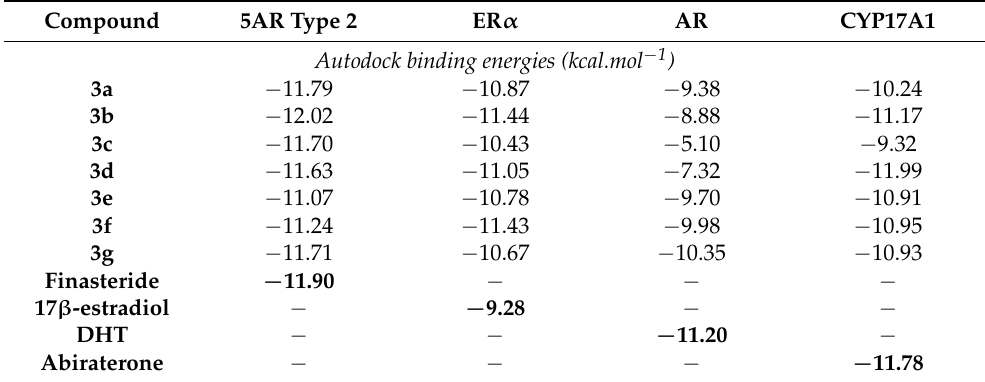
Table 4. Predicted binding energies of steroids 3a – g calculated from molecular docking against known protein targets of steroidal molecules: 5AR type 2, ER α , AR and CYP17A1. Binding energies of ligands (in bold) present in the X-ray crystal structures were calculated by re-docking 1 . Compound 5AR Type 2 ER α AR CYP17A1 Autodock binding energies (kcal.mol − 1